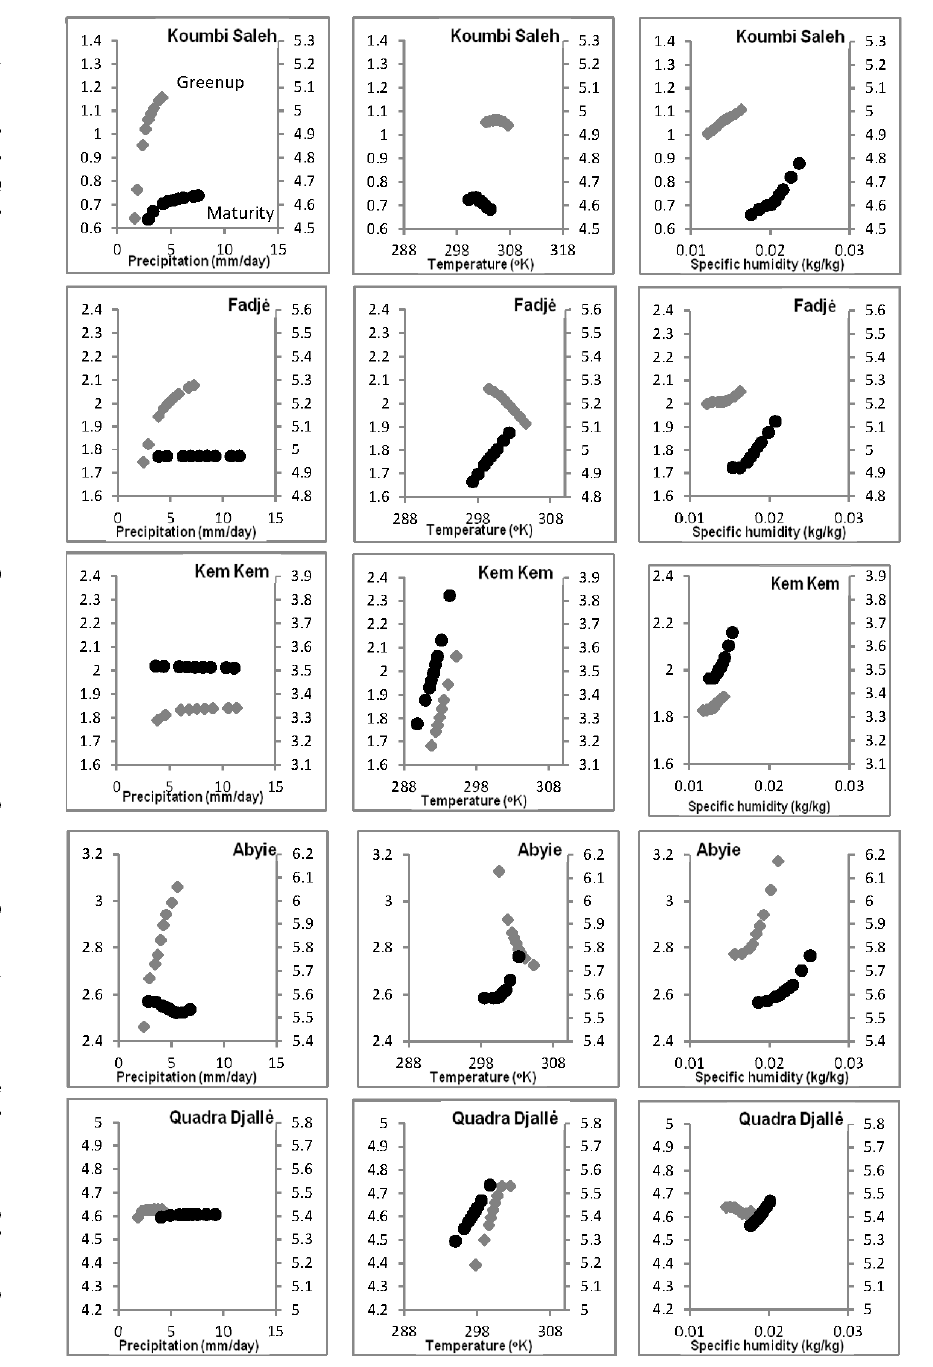
Figure 14. The response of net primary productivity (NPP) ( µ mol · m − 2 · s − 1 ) to changes in precipitation, temperature, and specific humidity averaged for the period from green-up to maturity (green-up period, grey diamonds; left hand axis) and from maturity to senescence (maturity period, black circles; right hand axis). Note the different ranges on the y axis between sites.